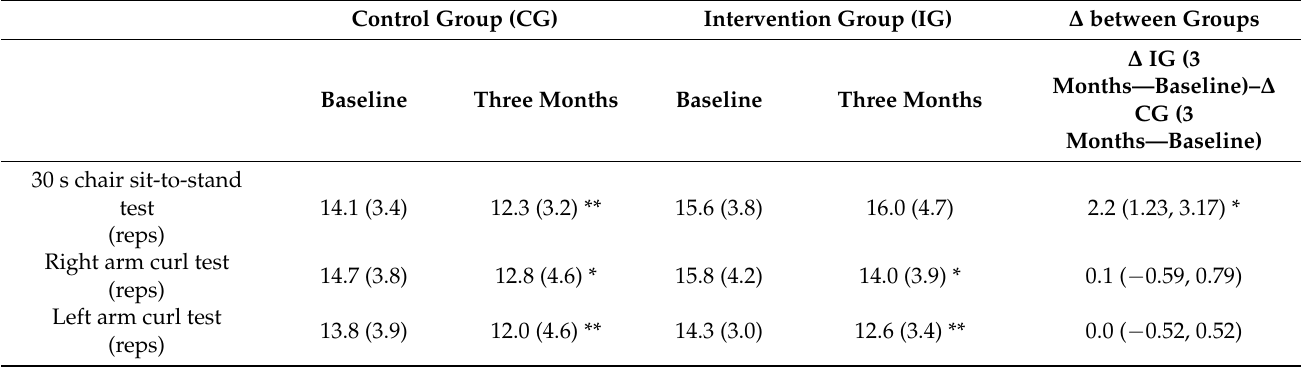
Table 4. Patients’ performance at strength